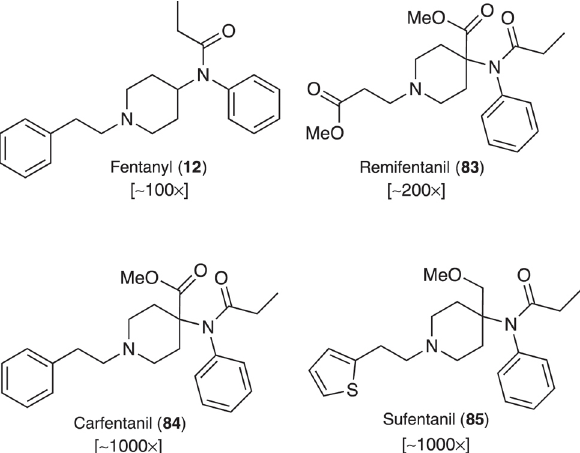
Figure 15: Selected members of the fentanyl class of synthetic opioids. The bracketed numbers represent their individual potencies relative to